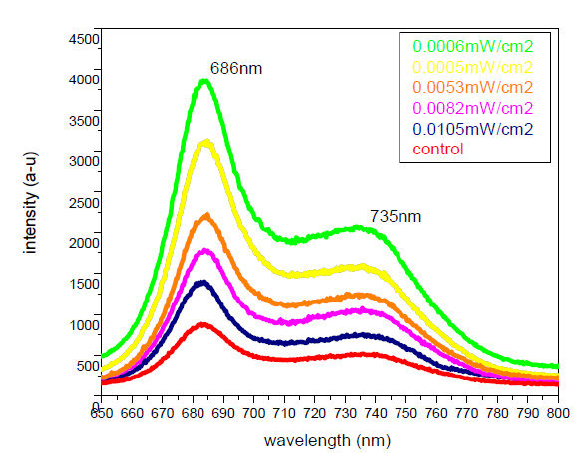
Figure 1: Steady-state fluorescence spectra of all groups of Green Mint, recorded at the same time after excitation by blue LED. Table 1. Fluorescence parameters calculated from spectra of control group of Green Mint after Gaussian fit.